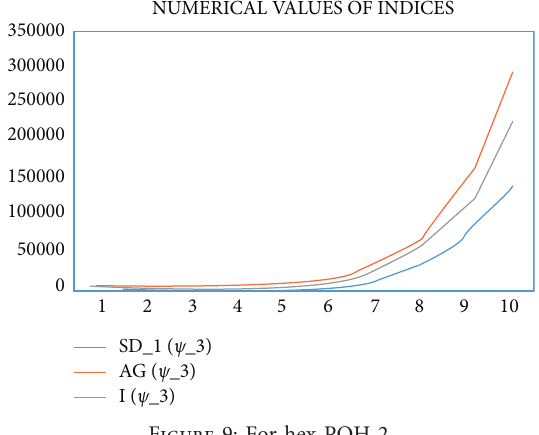
Figure 9: For hex POH